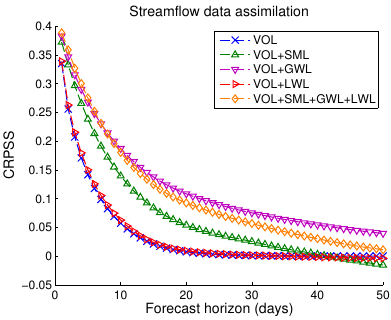
Figure 9. Continuous rank probability skill score of the streamflow ensemble when assimilating streamflow at the outlet. The open loop is used as a reference. The forecast horizon varies from 1 to 50